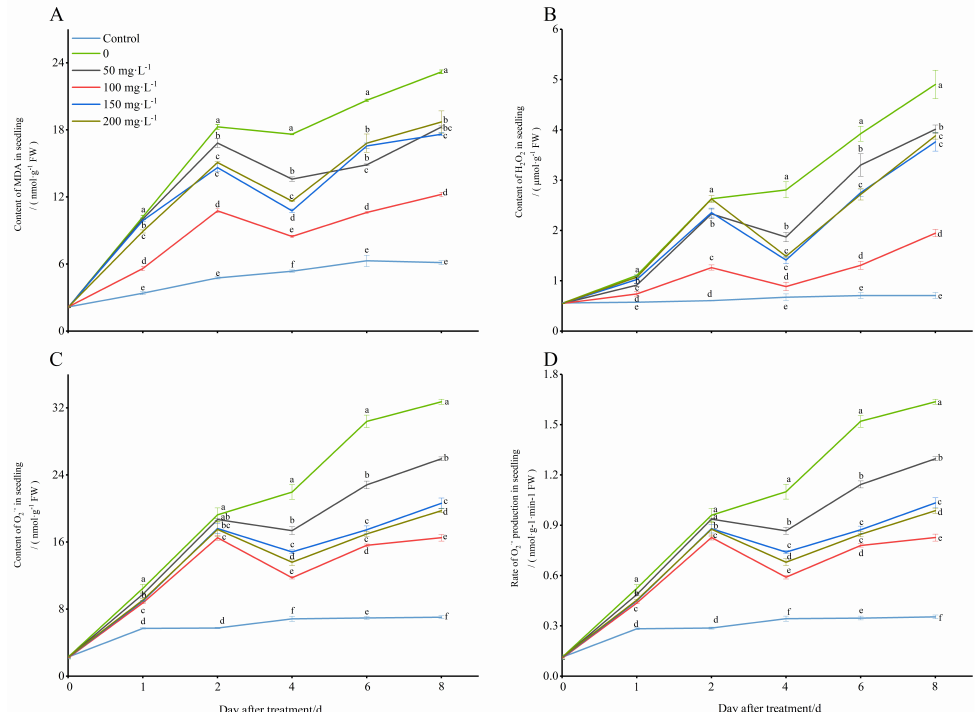
Figure 2. Changes in lipid peroxidation contents of peanut under low-temperature conditions (8 ◦ C). On each subgraph, different letters in the same column indicate significant differences in the p < 0.05 level. Data in the figure are presented as the mean ± standard deviation (n =